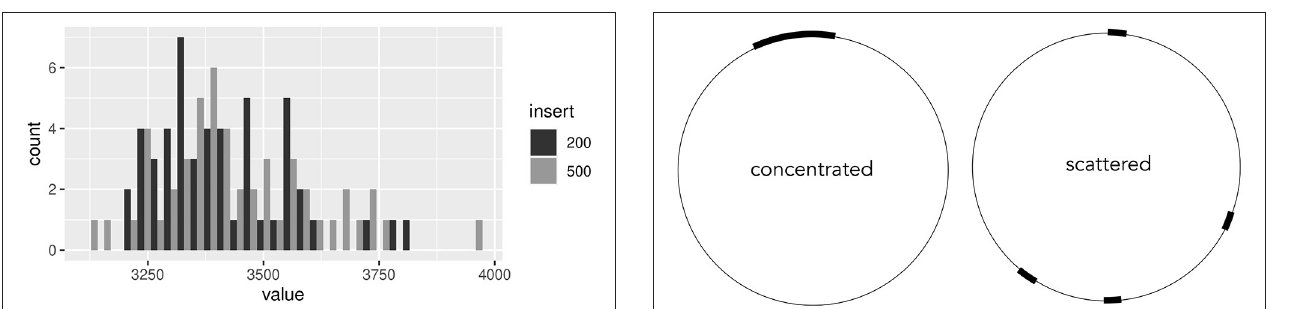
FIGURE 4 | Two hypothetical patterns of defect locations. One is concentrated at a location, but defect locations are scattered in the